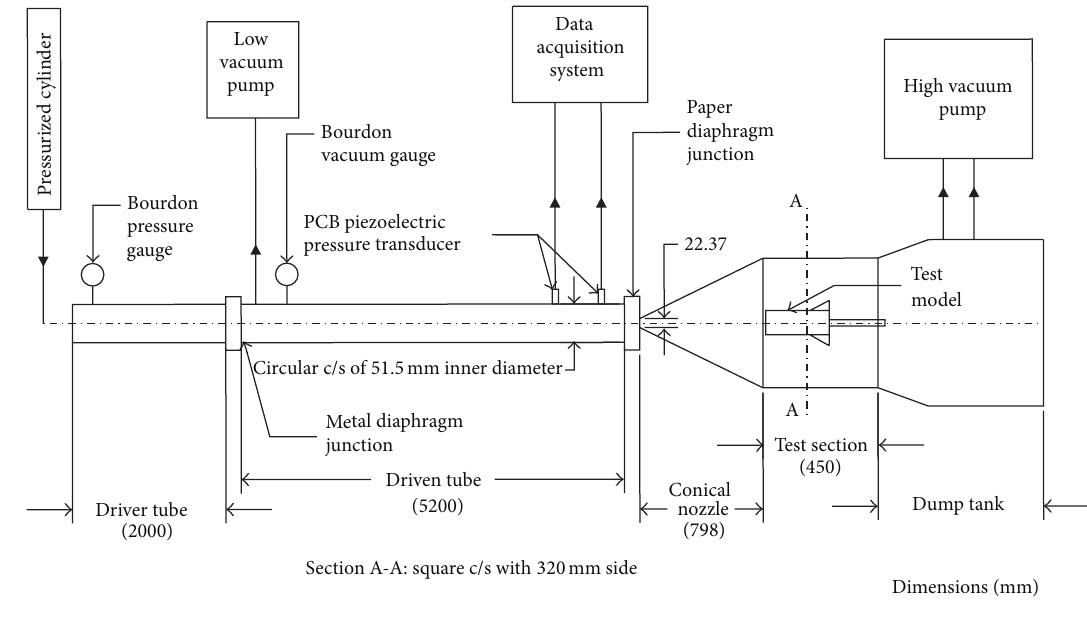
Figure 1: Schematic of the hypersonic shock tunnel, IITB-ST. Table 1: Freestream conditions for the tests in the shock tunnel.